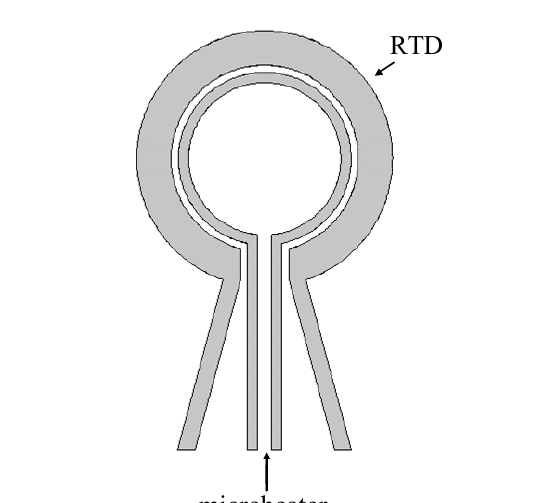
Figure 3. Schematic illustration of circular thermal flow meter.